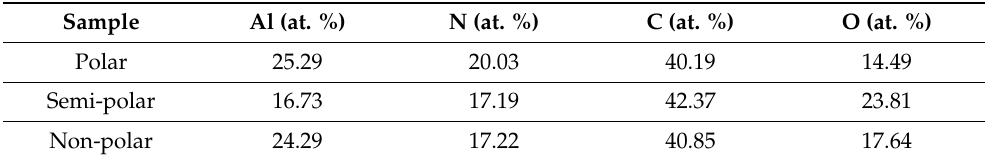
Table 3. The elemental concentrations of the polar, semi-polar and non-polar films with annealing at 1650 ◦ C. Sample Al (at. %) N (at.